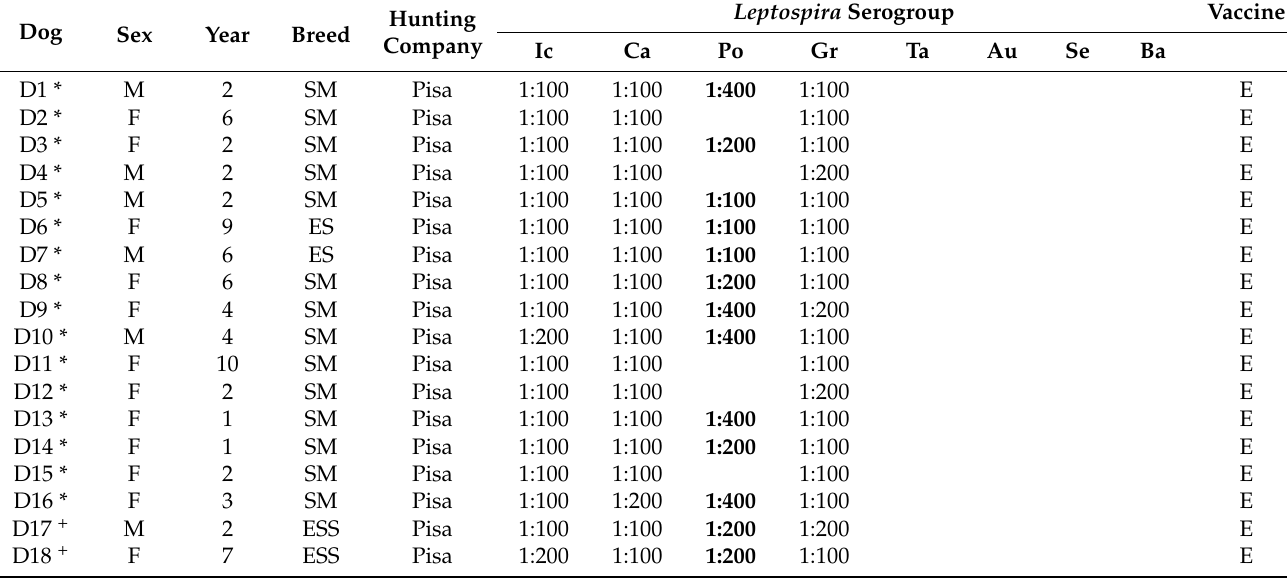
Table 1. Serological reactions detected in hunting dog sera in relation to Leptospira serogroups, their vaccination state, and hunting